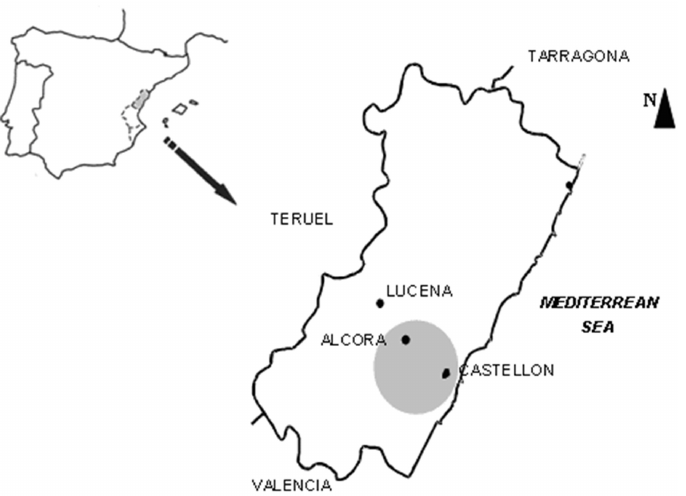
Figure 1. Location of the area studied (Scale 1:2,000,000).